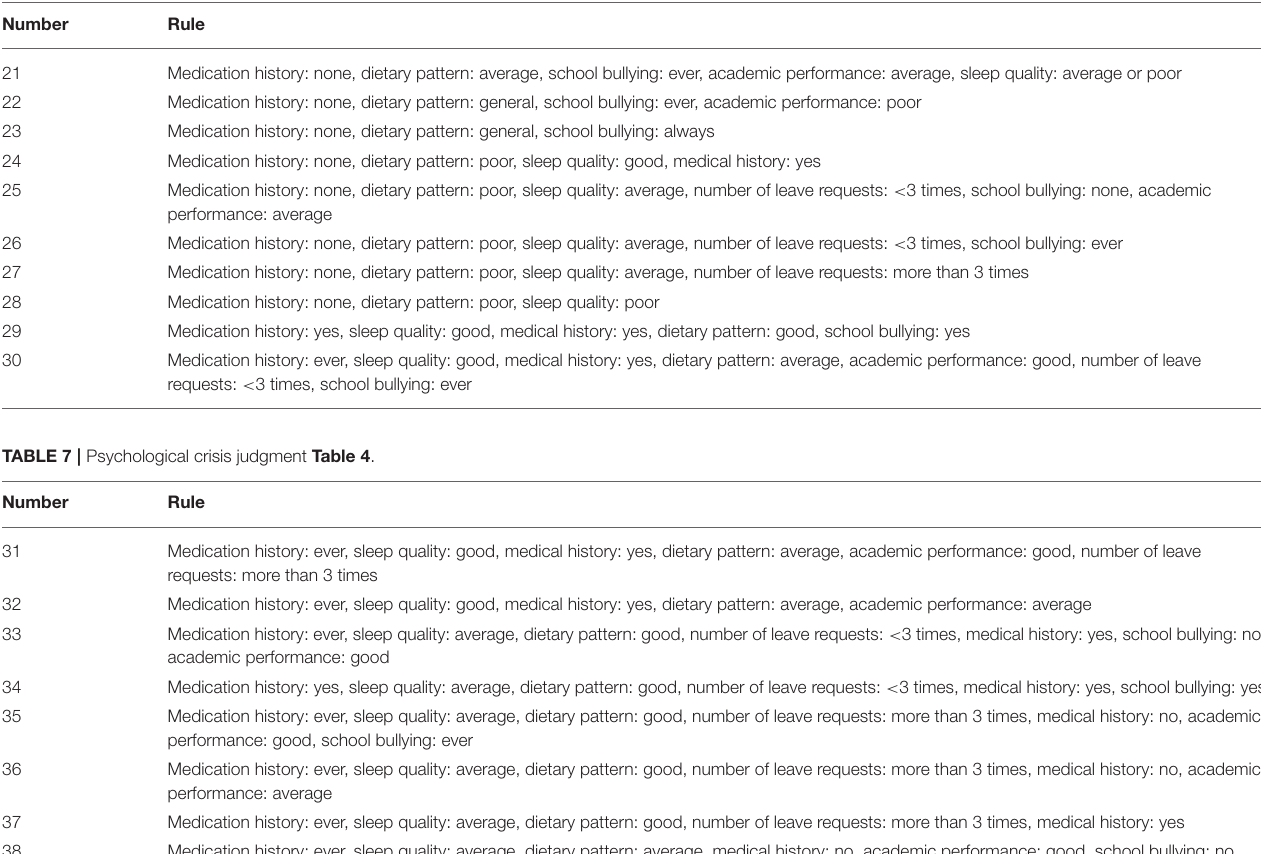
TABLE 6 | Psychological crisis judgment Table 3 .